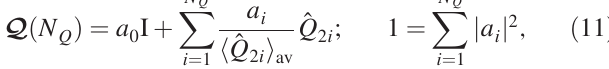
ˆ Q m ¼ 8 2 m g m ¼ 1 , while the